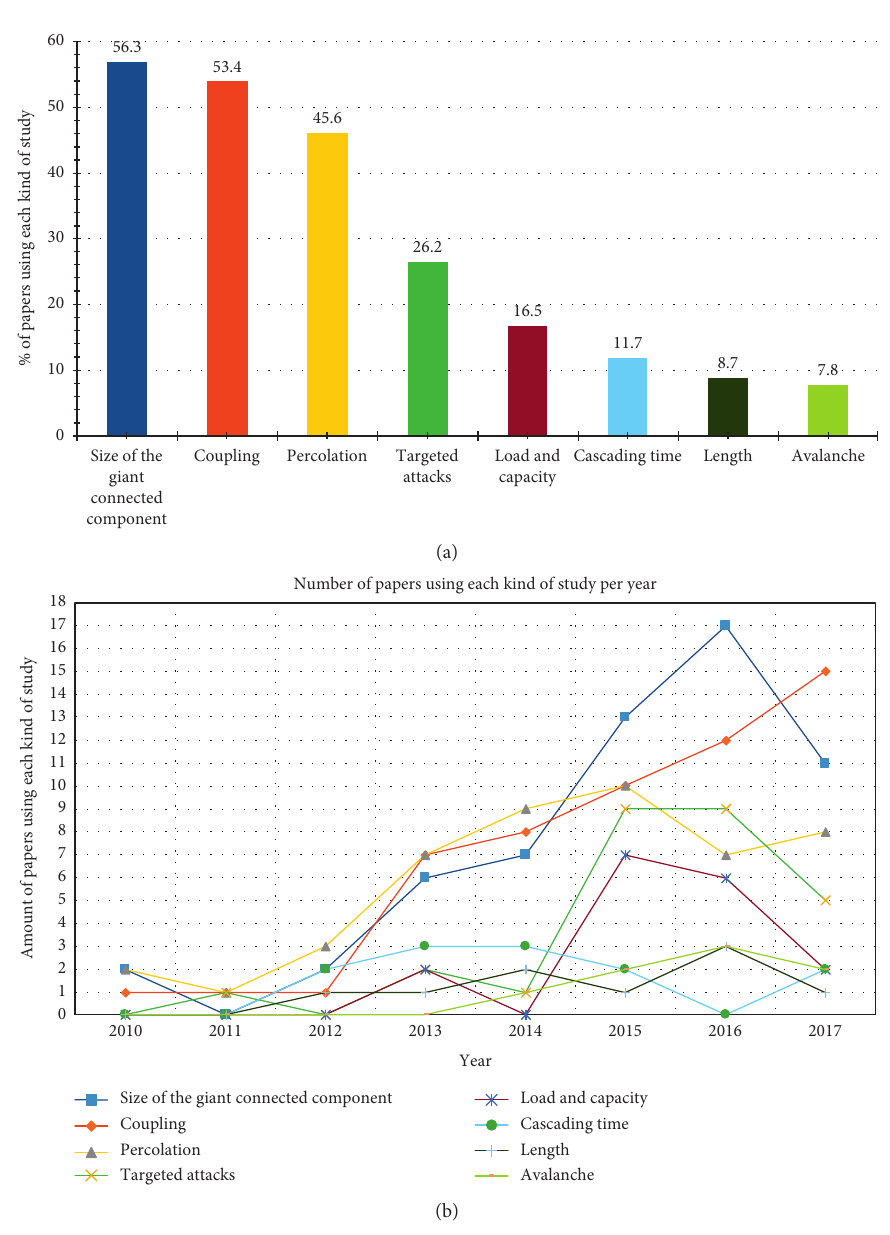
Figure 4: Studies performed among the articles reviewed. (a) Percentage of papers using each type of study. (b) Amount of papers per year using each type of